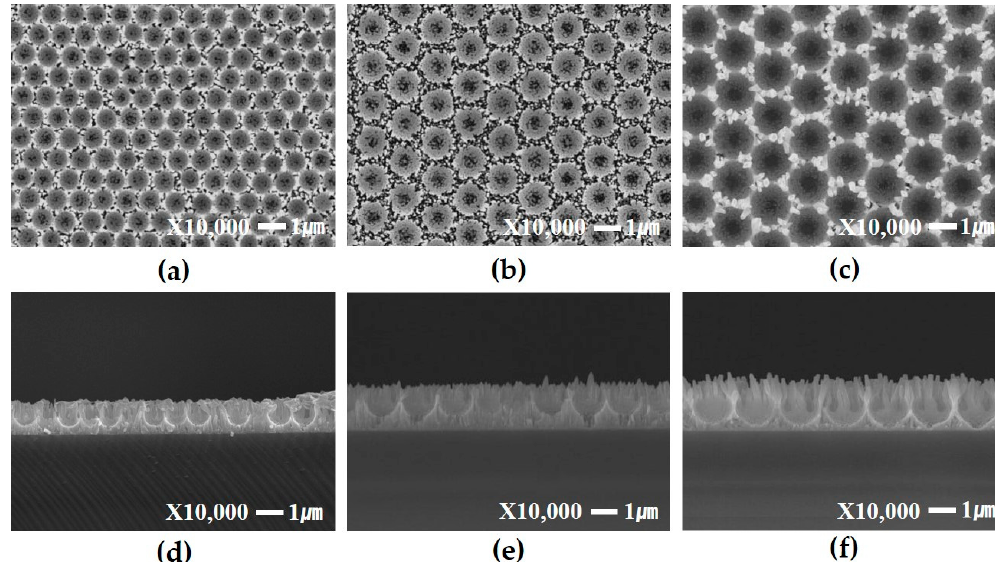
Figure 4. FE-SEM images of ZnO nanorod growth on quartz substrate by PS monolayer template without oxygen plasma treatment. Diameters of polystyrene are ( a ) 800 nm; ( b ) 1300 nm; ( c ) 1600 nm and cross-section of ( d ) 800 nm; ( e ) 1300 nm and ( f ) 1600 nm, resepectively.